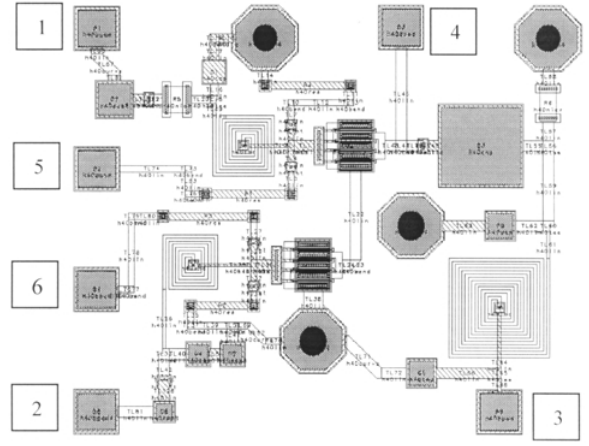
FIGURE 13 Final layout of the